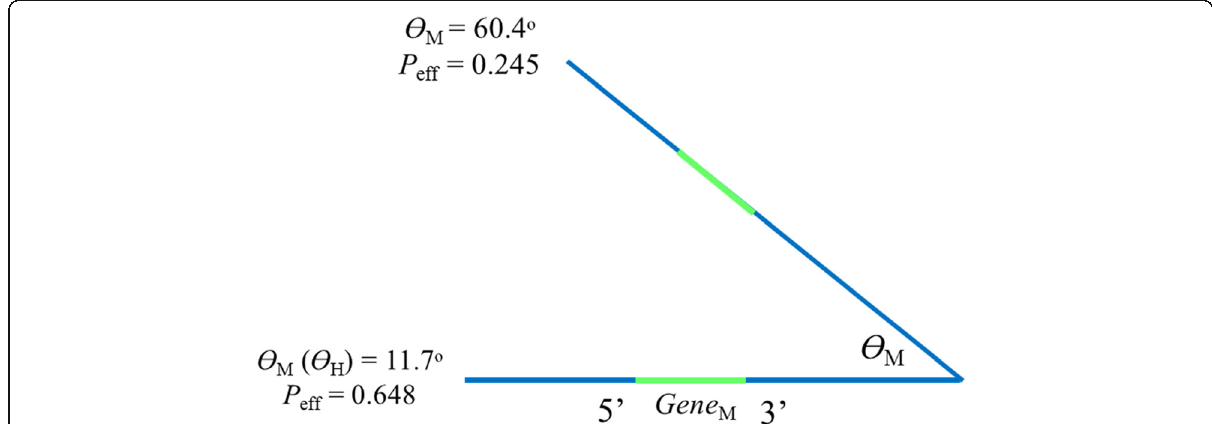
Fig. 3 Angulation of intergene base arc distance tropy in reference to the z , x -axis horizontal plane mesotropic heterochromatin loop segment genes. Mesotropic heterochromatin strand loop micro-structural arrangement is a series of ≥ 3 intergene base distance-separated genes perceiving the lesser grade asymmetric tropy viscosity effect with nano-compliance of the same, Θ M. RNA/ncRNA class gene locus ENSG00000224276 / LOC105371729 ( P eff , 0.260)-containing mesotropic form heterochromatin strand loop segment consisting of three genes in- series is arranged as ENSG00000224276 / LOC105371729 ( Θ M = 58.6 0 )- GC01P156042 ( LAMTOR2 ) ( Θ M = 58.7 0 )- RAB25 ( Θ M = 57.4 0 ) from 5 ’ to 3 ’ on the forward (+) strand of human ch 1q22 at positions -3 through -1 in reference to LMNA ; and the heavy chain immunoglobin gene locus ( IGH_ ) containing mesotropic form heterochromatin strand loop segment consisting of 8 diversity genes in-series is arranged as IGHD1-20 ( nf ) ( Θ M = 41 0 )- IGHD6-19 ( Θ M = 52.7 0 )- IGHD5-18 ( Θ M = 59.3 0 )- IGHD4-17 ( Θ M = 52.5 0 )- IGHD3-16 ( Θ M = 52.8 0 )- IGHD2-15 ( Θ M = 54.5 0 )- IGHD1-14 ( Θ M = 54.7 0 )- IGHD6-13 ( Θ M = 55.4 0 ) from 3 ’ to 5 ’ on the reverse (-) strand of human ch 14q32.3 in native configuration. As shown is a gene of a mesotropic heterochromatin segment loop positioned at the lower limit of angulation Θ M = 11.7 0 in the z , y -vertical plane that horizontally aligns for transcription in z , x -axis at a P e ff of 0.648 esebssiwaagoT Q units. Legend. Θ H, zero degree horizontal; d M , hypotenusal distance of anisotropic gene intergene tropy bases; d M sin Θ M , distance to horizontal for anisotropic gene intergene tropy distance; d M at H 0 = 0 0 , d M ·cos Θ M + x M ; P effective intracellular pressure ( P eff ) = P effective intranuclear